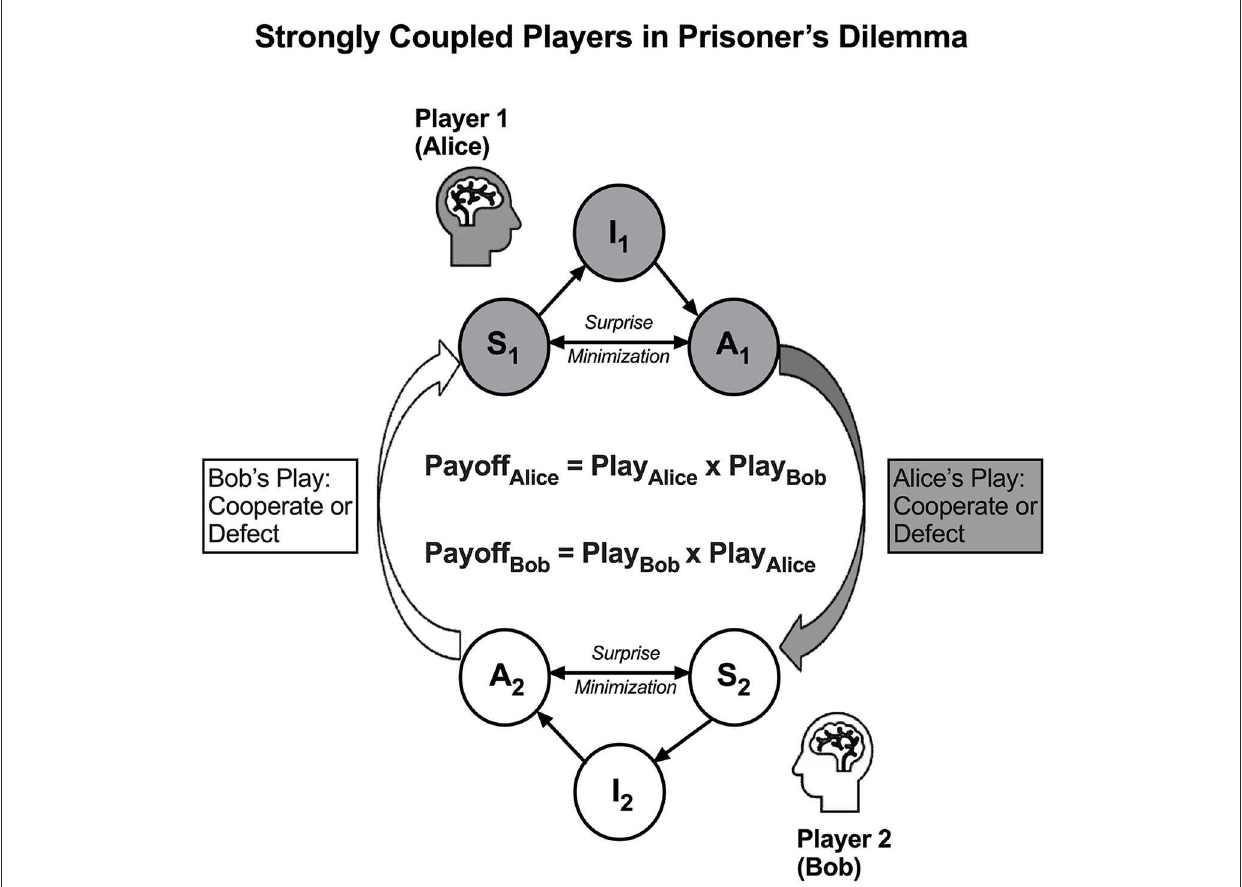
FIGURE4 Dyadic active inference model in reiterated prisoner’s dilemma: when two players (Alice as Player 1 and Bob as Player 2) are strongly coupled, one person’s active states outputs become the total inputs of the other person’s sensory states, and vice versa, i.e., (A 1 ) causes (S 2 ) and (A 2 ) causes (S 1 ), the surprise in Persons 1 and 2 are also coupled and thus the strategies in their internal states (I 1 and I 2 ) are optimized collectively. The results (S 1 and S 2 ), i.e., payoffs, are determined by the interaction between the players’ plays (A 1 and A 2 ), i.e., Payoff Alice = Play Alice × Play Bob and Payoff Bob = Play Bob × Play Alice , as if they are performing a multidimensional dyadic